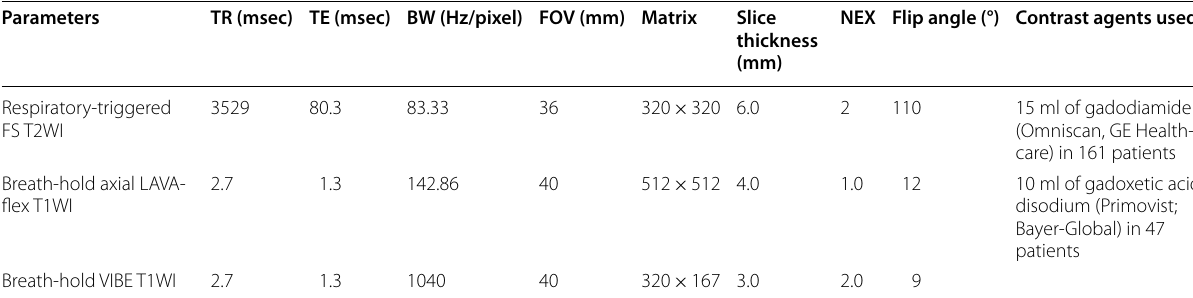
Table 1 Imaging